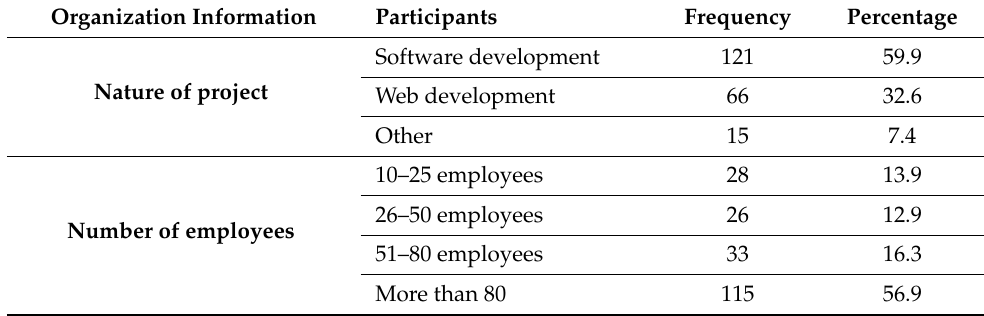
Table 5. Organization-related information of the conducted questionnaire.